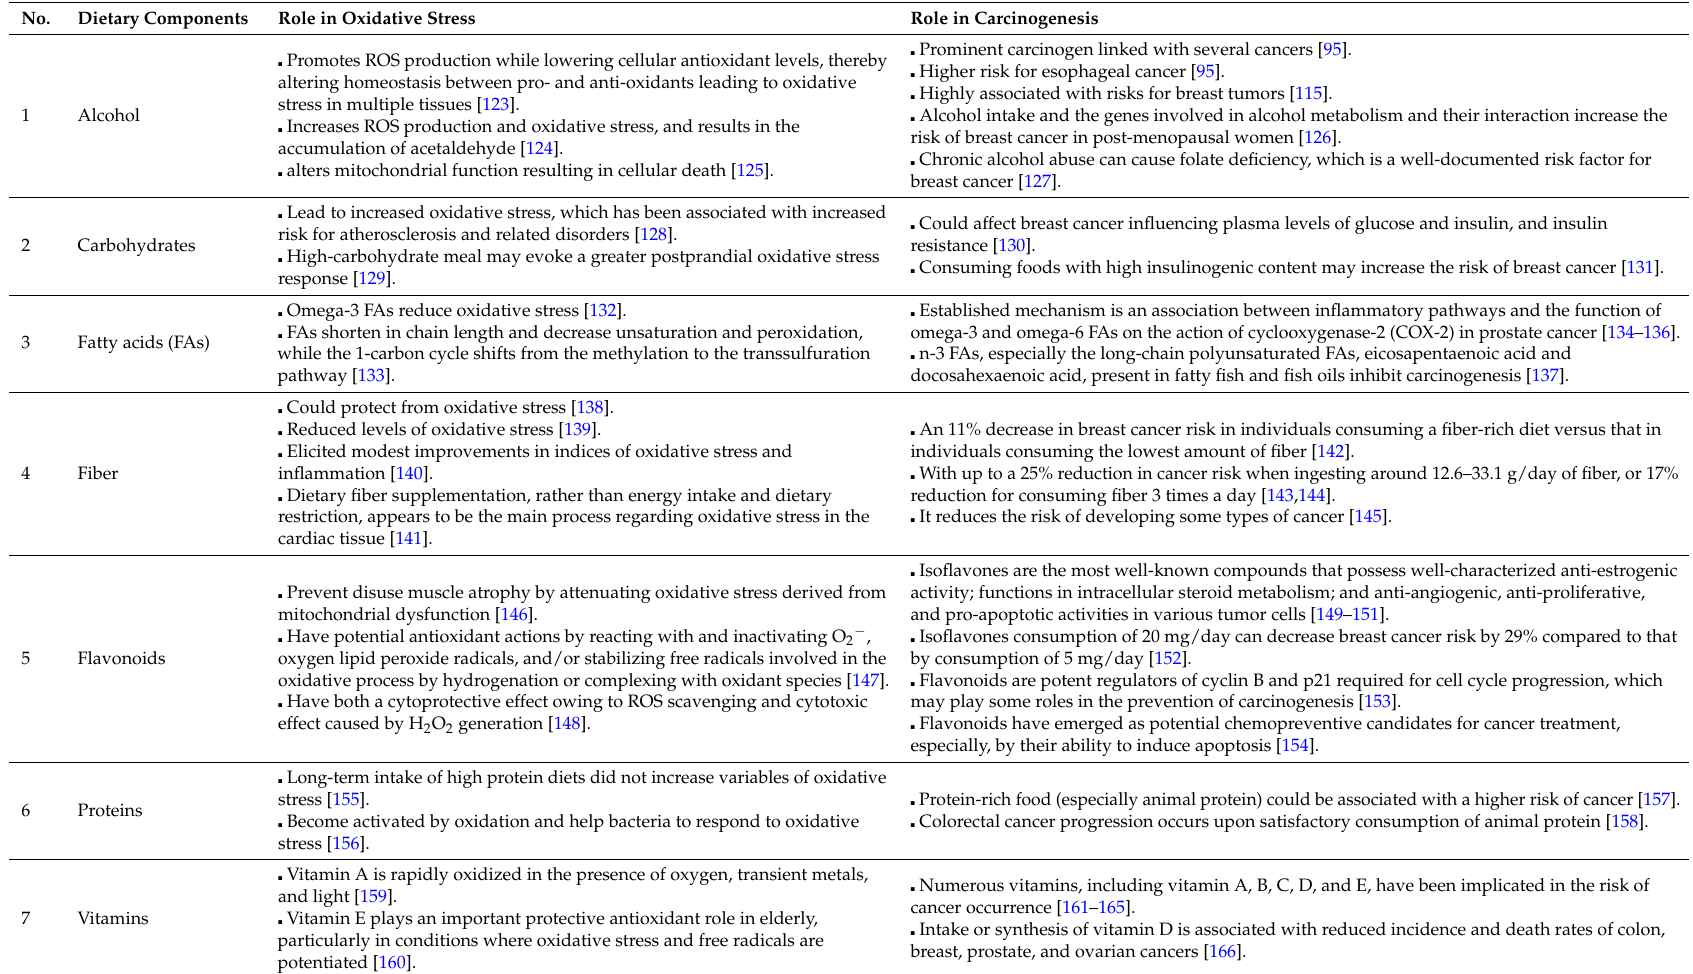
Table 1. The role of various dietary components in oxidative stress and